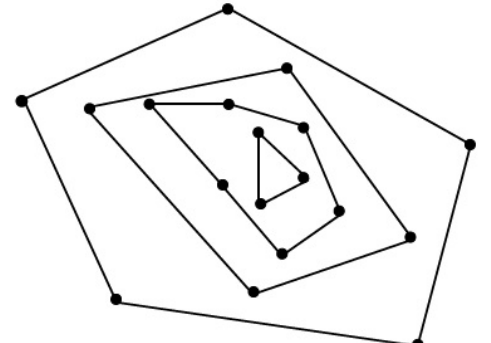
Figure 12: Final convex layers.